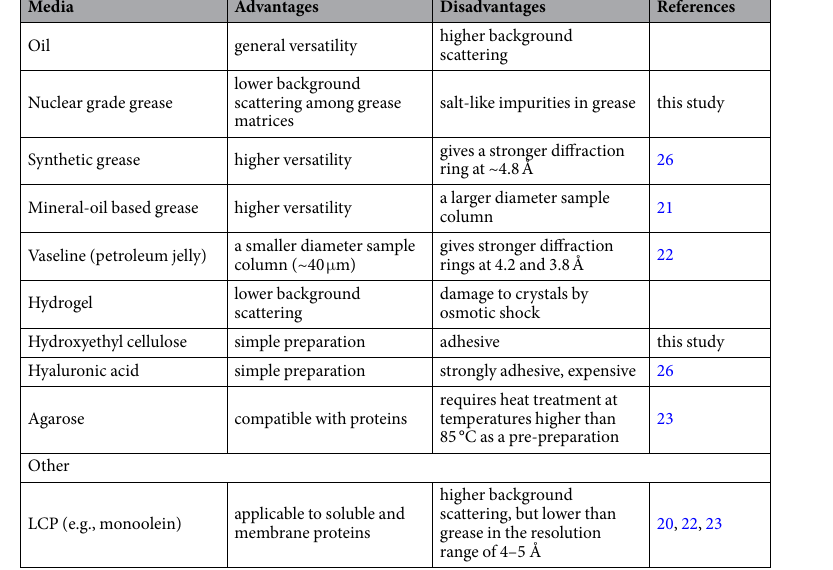
Table 2. Crystal carrier media for serial sample